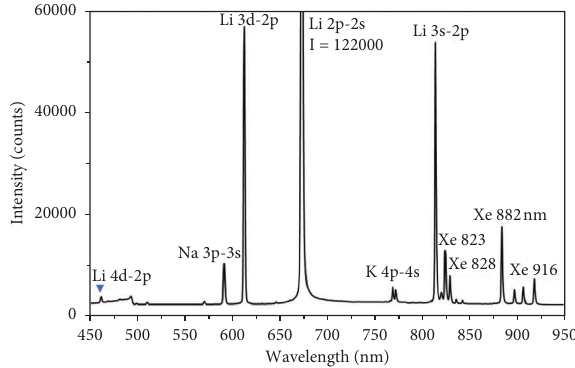
Figure 3: The emission spectrum of the Kr-Xe mixture at a temperature of 673 K F � 10 14 n/cm 2 s. Integration time is 30ms.